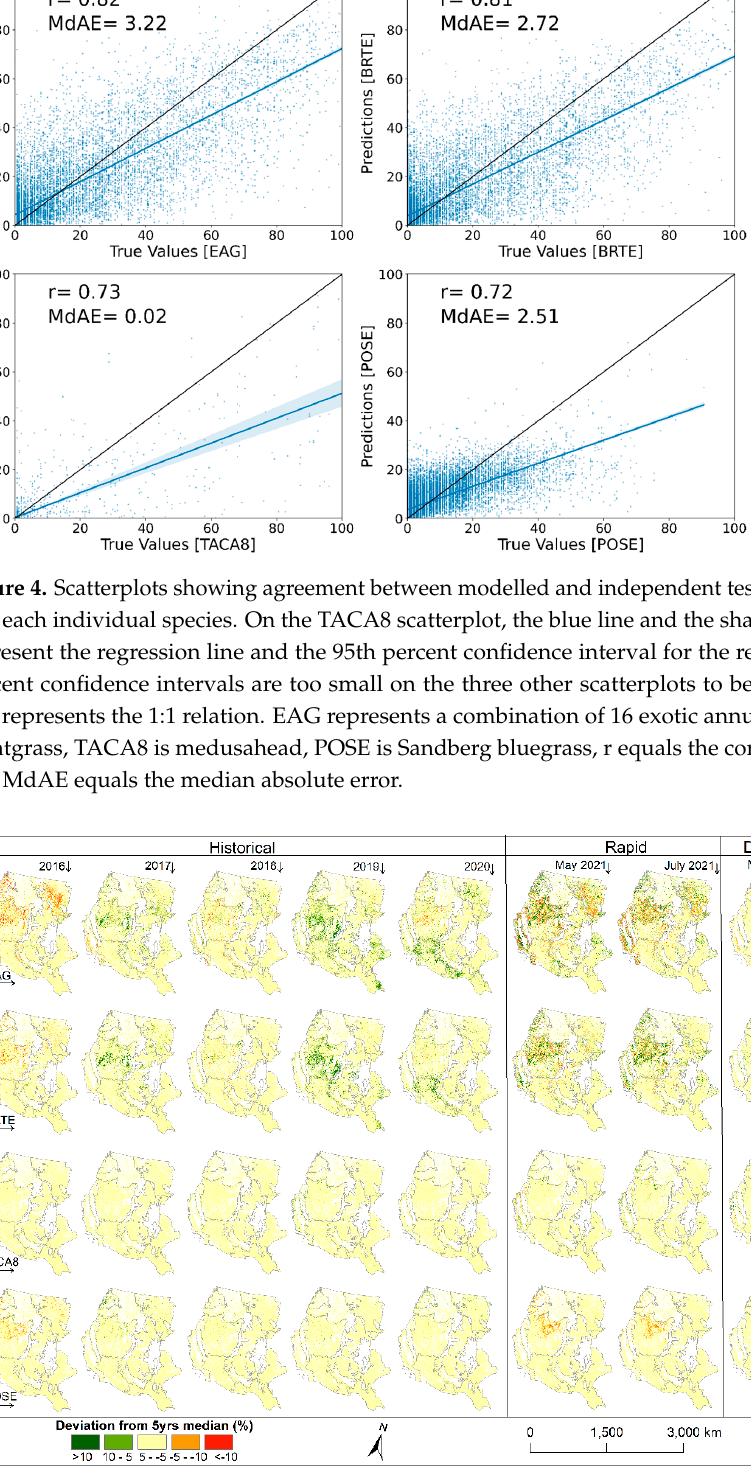
Figure 5. Historical ( left ) and rapid ( center ) deviation maps of the annual species abundance from the long-term (2016–2021) median percent cover. Estimated abundances lower than the median are displayed in red, while estimated abundances higher than the median are displayed in green. The difference ( right ) of the two rapid maps (May–July 2021) shows higher abundances in May dis- played in red with lower abundances in July displayed in green. EAG represents a combination of 16 exotic annual grasses, BRTE is cheatgrass, TACA8 is medusahead, and POSE is Sandberg blue- grass.